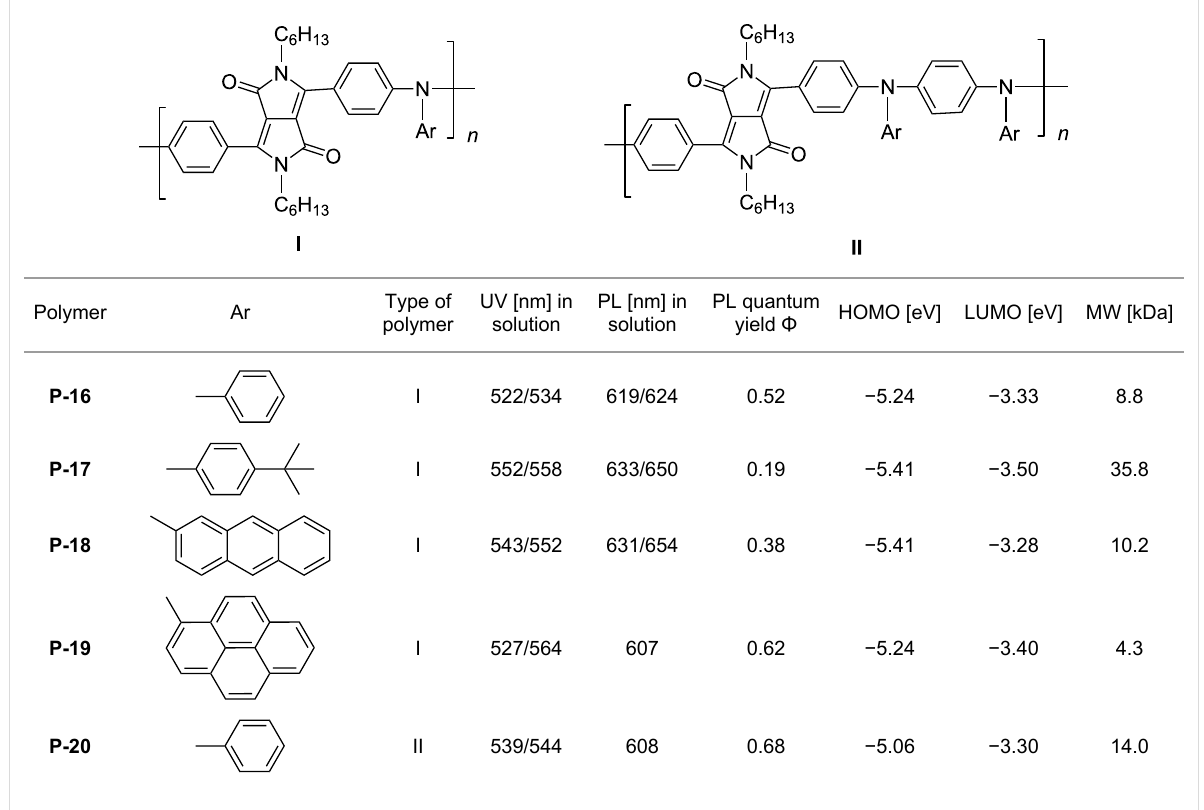
Table 3: List of DPP-based polyiminoarylenes and their characteristic properties